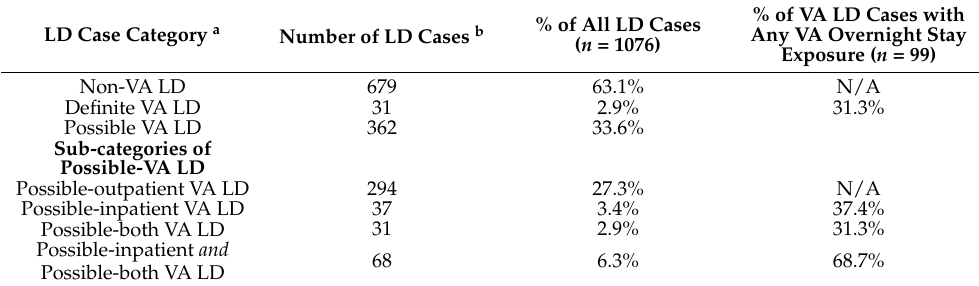
Table A1. LD case classifications by VA healthcare